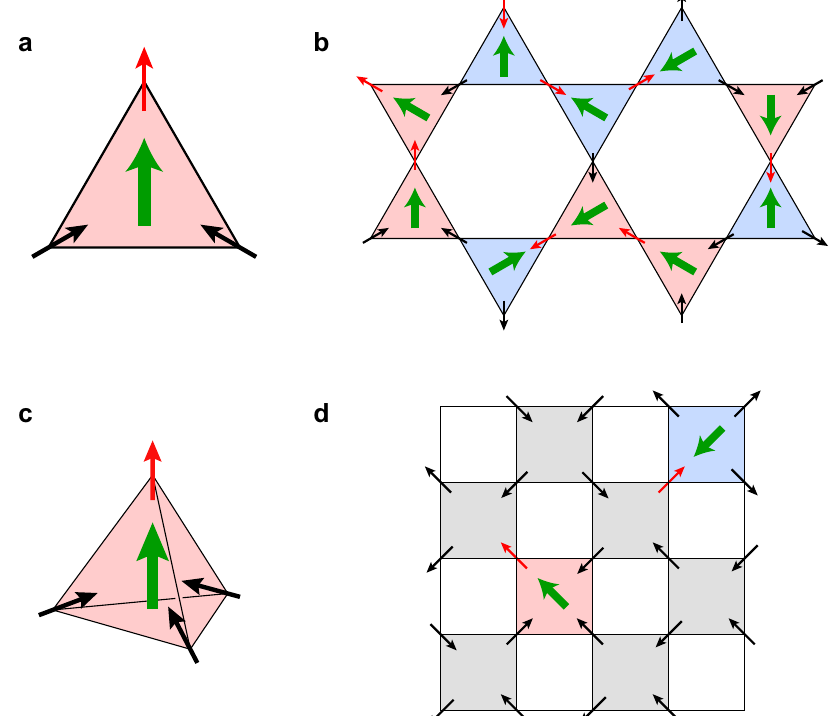
Fig. 1 The appearance of an electric dipole on a magnetic monopole. a The triangle (a building block of kagome ice). The dipole points towards the ‘ special ’ spin (red arrow). b Spin ice kagome lattice with random monopoles ( μ ) and antimonopoles ( (cid:1) μ ) and random dipoles. c The tetrahedron (the building block of pyrochlores) with a monopole. The dipole points to the ‘ special ’ spin (red arrow): the out-spin in the monopole with the (3-in) – (1-out) con fi guration, and the in-spin in the antimonopole with the (1-in) – (3-out) con fi guration. d A typical con fi guration of pyrochlore spin ice with random monopoles ( μ ) and antimonopoles ( (cid:1) μ ) and the electric dipoles associated with them shown on a schematic representation of this state on a 2d plot. The monopoles are marked by pink and antimonopoles by blue colour; electric dipoles are shown by thick green